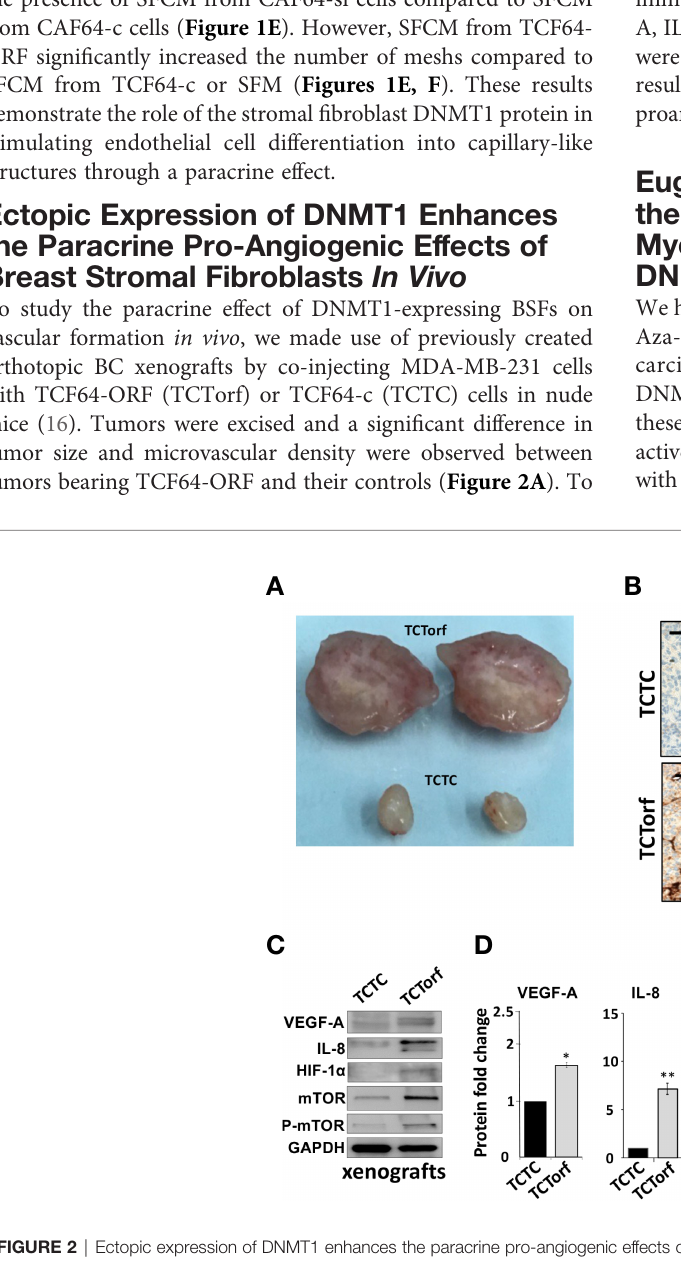
FIGURE 2 | Ectopic expression of DNMT1 enhances the paracrine pro-angiogenic effects of breast stromal fi broblasts in vivo . Orthotopic BC xenografts were created by co-injecting MDA-MB-231 cells with TCF64-orf or TCF64-c cells under the nipple of nude mice as previously described (16). (A) Picture of excised tumors (B) Immunohistochemical staining was carried out on FFPE sections using an anti – CD-31 antibody. Scale bars represent 200 m M. (C) Whole-cell lysates were prepared from the excised tumors, and then were used for immunoblotting analysis using speci fi c antibodies against the indicated proteins. (D) The histograms show the averaged protein level fold changes relative to the control (TCTC) after normalization against the internal control GAPDH, while the level of the phospho- protein was further normalized to the level of the total protein. Error bars represent mean ± S.D (n=3). * P <0.05 and